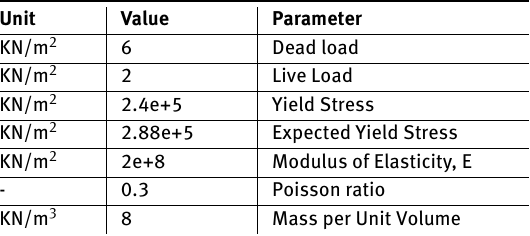
Table 1: Modeling and designing parameters.